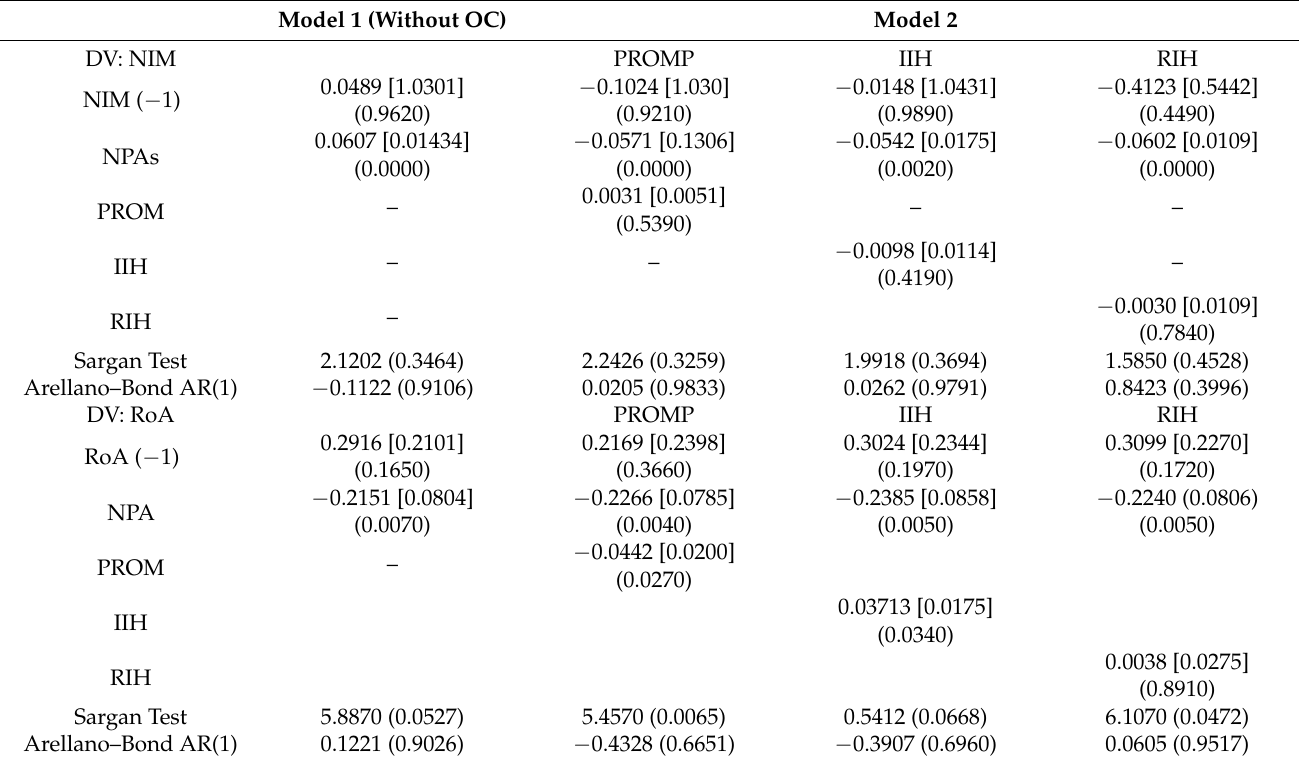
Table 5. Regression results: profitability (NIM/ROA) as the dependent variable on